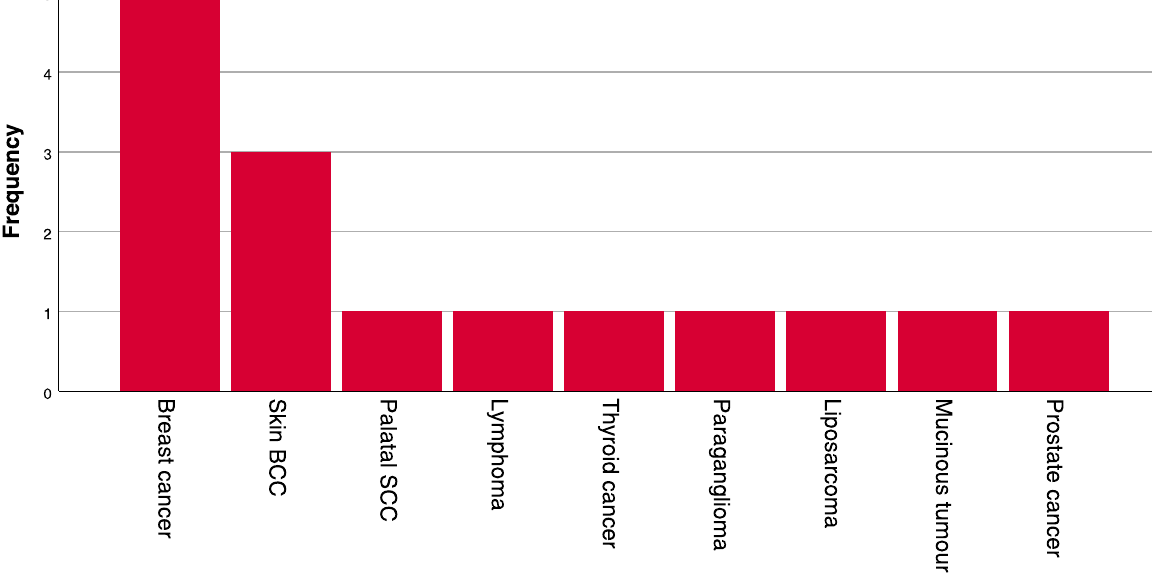
Fig. 1 A bar chart showing the frequency of tumor associated with